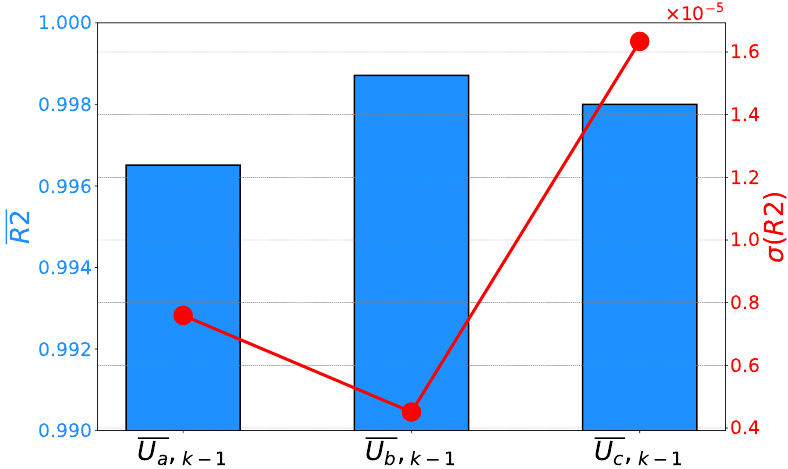
Figure 8. Mean R 2 scores and their standard deviations achieved on the prediction of phase